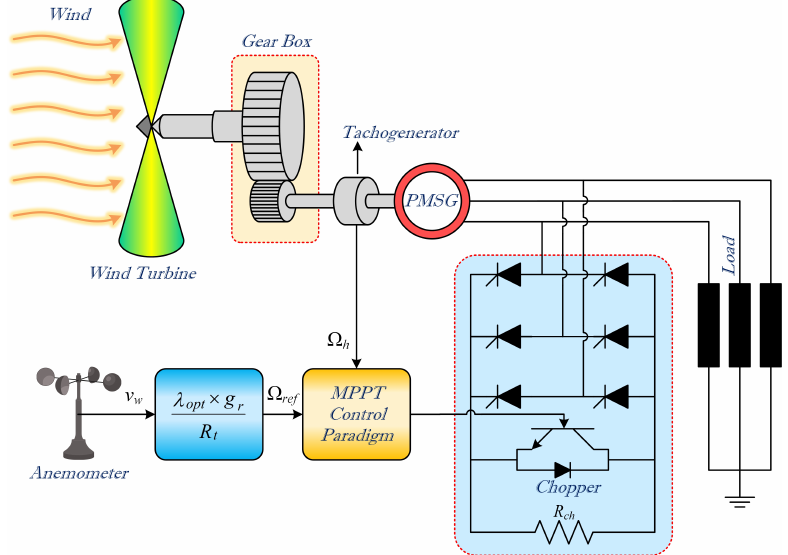
Figure 1. Schematic of the overall variable speed permanent magnet synchronous generator–wind energy conversion system